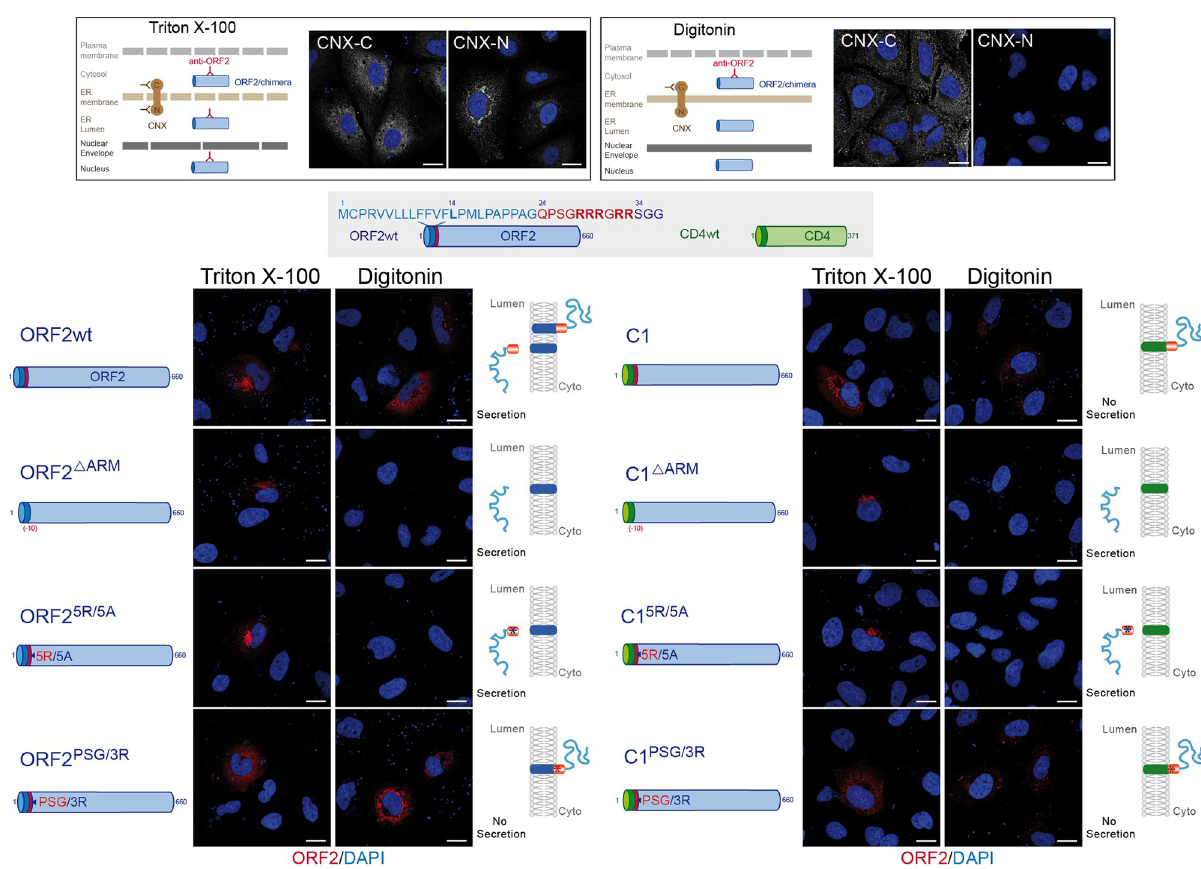
Fig 7. The ORF2 ARM regulates the topology of ORF2 SP. A schematic representation of differential permeabilization process with Triton X-100 and Digitonin is shown. Representative images of the differential detection of two epitopes on the ER-membrane associated Calnexin (CNX) used to assess the permeabilization conditions are shown. H7-T7-IZ cells were transfected with pTM plasmids expressing wt, mutant or chimeric ORF2 proteins. Twenty-four hours post-transfection, cells were fixed, permeabilized with either Triton X-100 or Digitonin, and processed for ORF2 staining (in red). Nuclei are in blue. Representative confocal merge ORF2/DAPI images are shown (magnification x63). Blue dots observed in some pictures are DAPI- stained transfected plasmids. A schematic representation of each construct is shown on the left and its predicted topology on the right. Blue and red asterisks correspond to 5R/5A and PSG/3R mutations, respectively. Scale bar, 20 μ